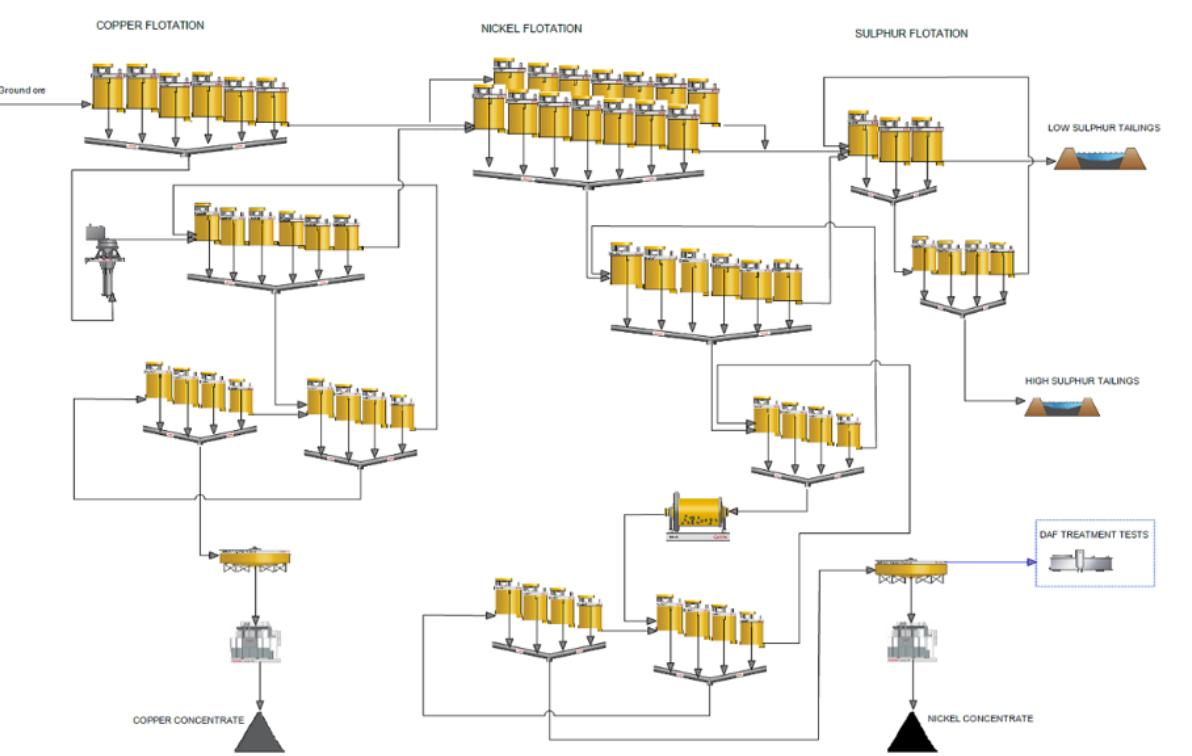
Figure 1. Overall flowsheet of Kevitsa concentrator plant with the sampling point for the process water. Table 2. Particle size distribution for the ground flotation feed.